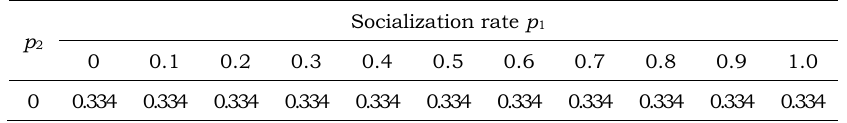
Table 1. Average knowledge levels at the learning rate p 2  0